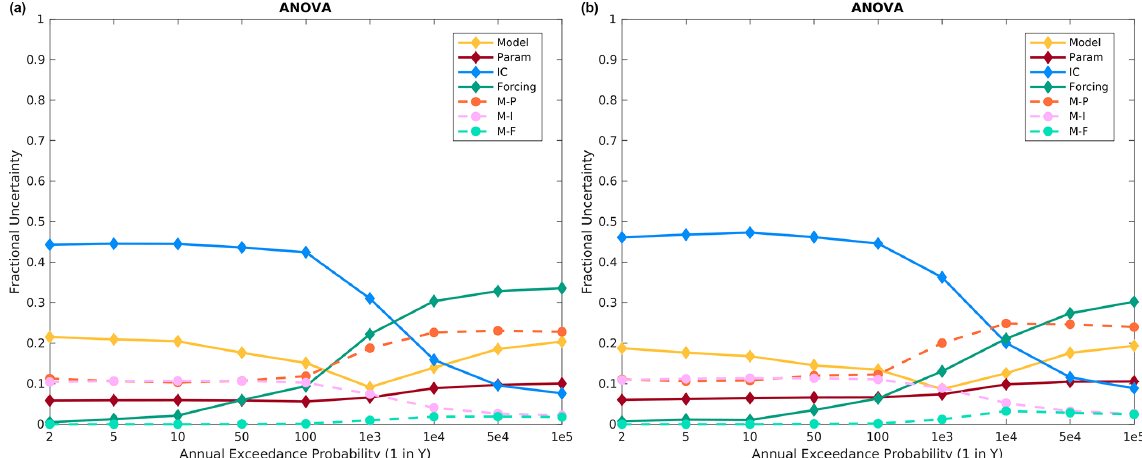
Figure 9. Island Park fractional variance contributions using the three base models, namely HEC-HMS (model 1), VIC (model 2), and SAC-SMA (model 3), for the (a) specified meteorological sequence and (b) historical meteorological sequence.